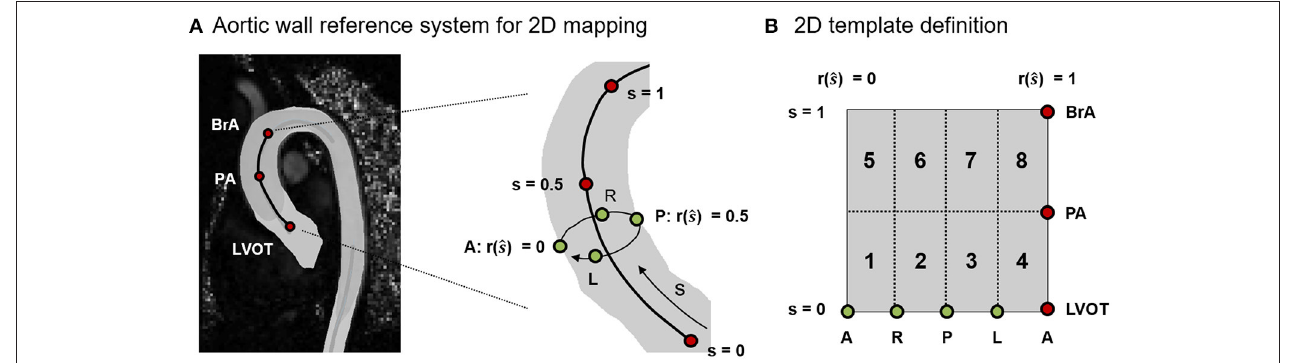
FIGURE 3 | (A) Definition of the normalized reference system used to map on a 2D template the spatial localization of points on the 3D aortic wall. The longitudinal s , the circumferential position is represented by r( position of points is represented by s ( s 0 at LVOT and s 1 at BrA). For a given cross section at s = = = ˆ (B) Sub-division of the 2D template into 8 sectors based on the anatomical landmarks (LVOT, PA, BrA) and orientation points (Antero: A, Posterior: P, Left: L, Right: